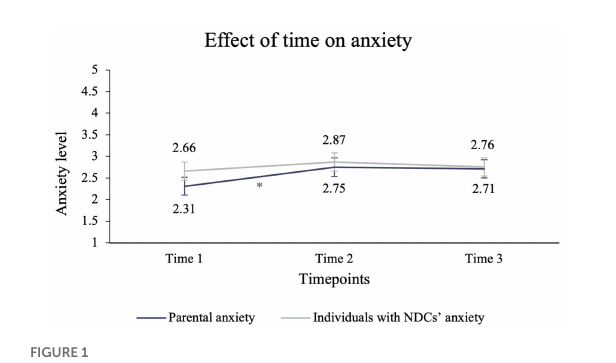
FIGURE 1 Anxiety for individuals with NDCs and their parents at the three timepoints. Time 1: “before COVID-19”; Time 2: “when the pandemic started”; Time 3: “at the time of completion of the questionnaire” – time frame between April 8 and June 27, 2020. Anxiety is measured with a 5-point Likert scale from 1 (not anxious) to 5 (very anxious). The anxiety level of individuals with NDCs was reported by their parents or caregivers. NDCs = neurodevelopmental